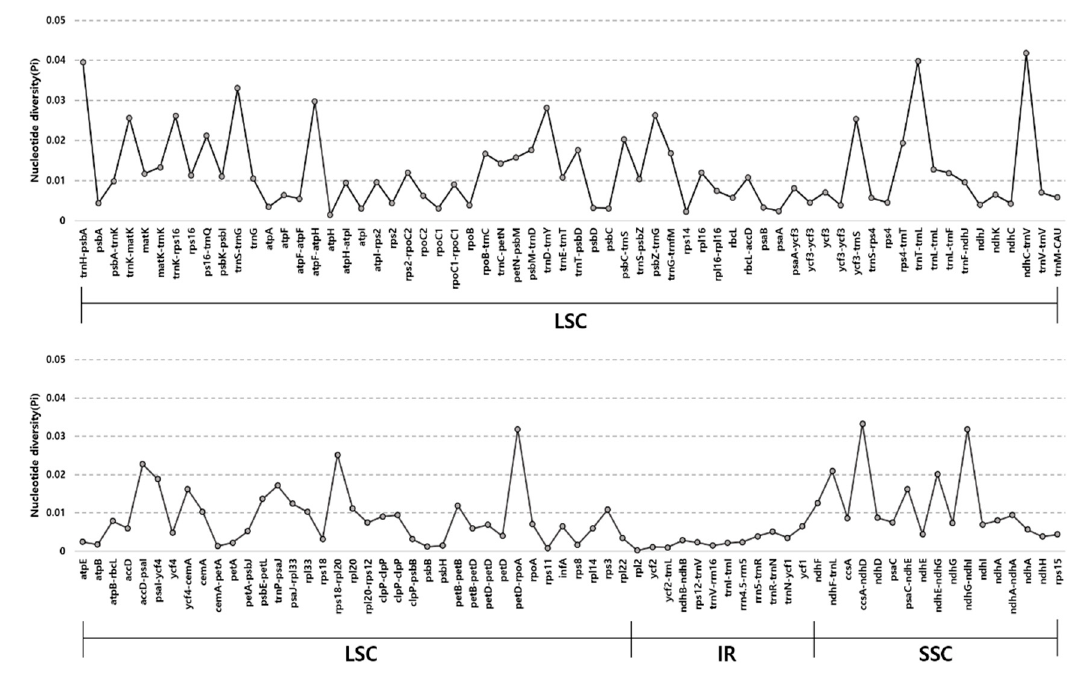
Figure 3. Comparison of nucleotide diversity (Pi) in the cp genomes of six Actaea species, including A. simplex , A. dahurica , A. biternata , A. heracleifolia , A. asiatica , and A. vaginata .